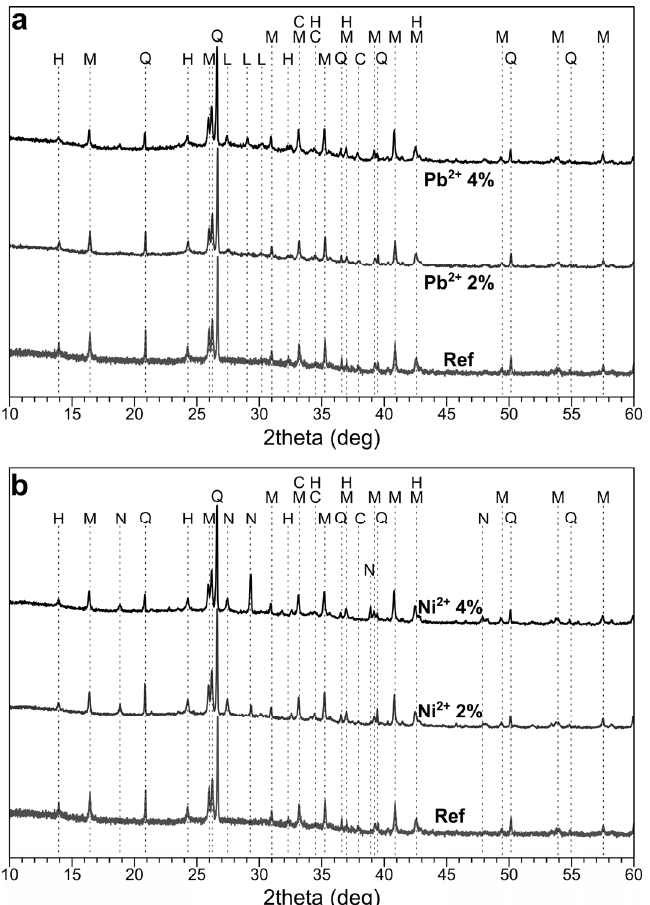
Figure 9. The XRD patterns of the geopolymers with heavy metals and without boron: ( a ) Pb 2+ and ( b ) Ni 2+ (H—hydroxysodalite; M—mullite; Q—quartz; C—sodium carbonate; L—lead oxide; N—nickel compounds; S—nitratine).